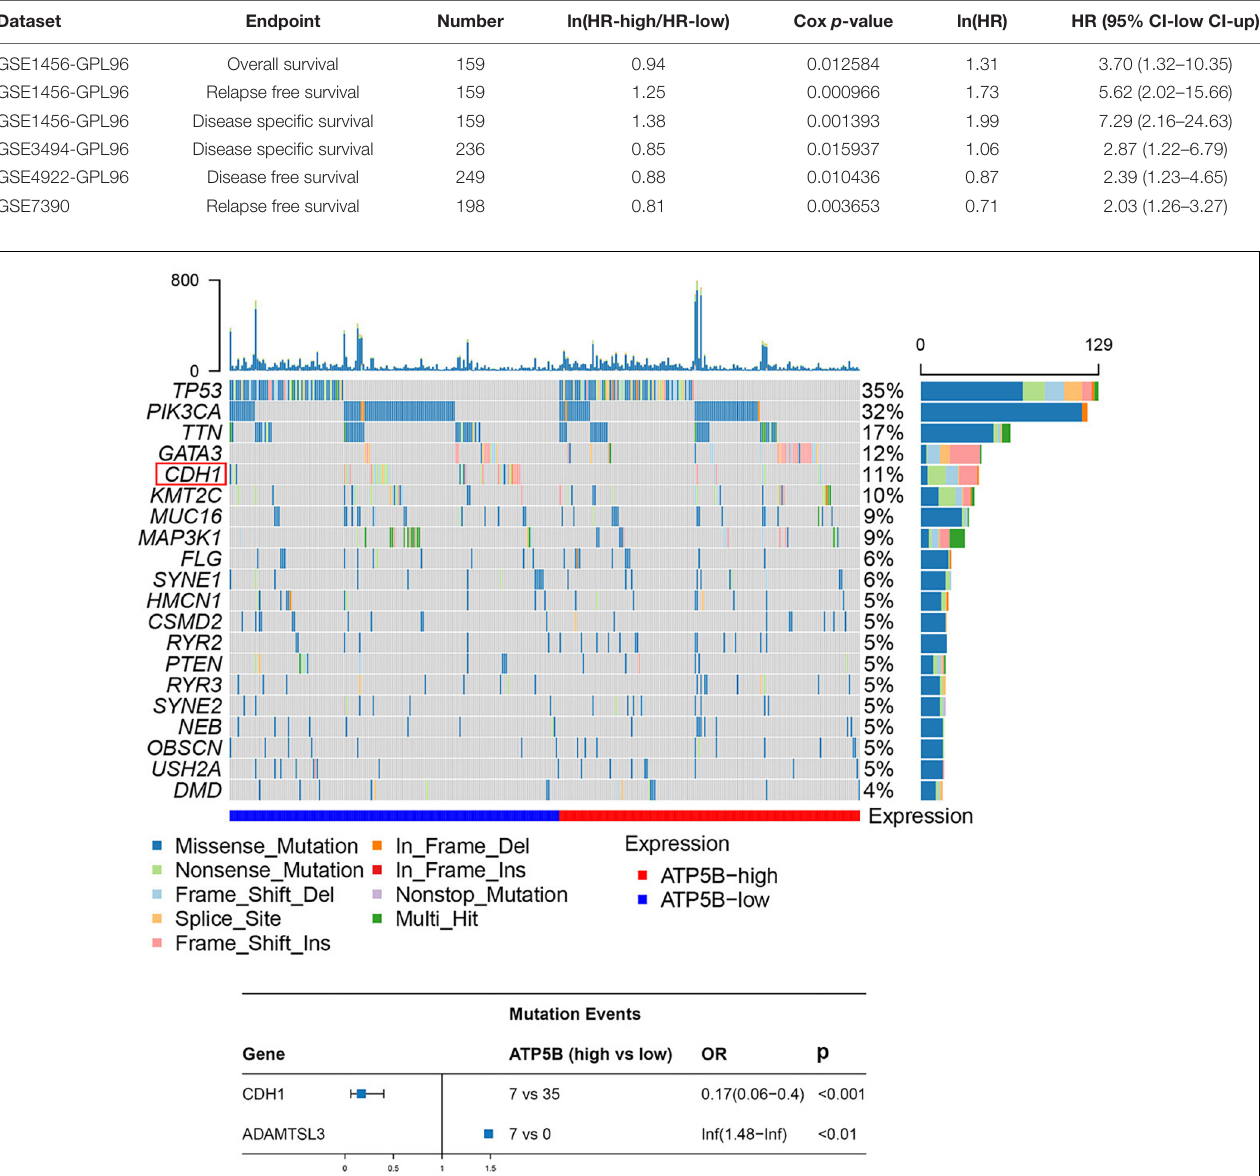
TABLE 3 | Survival analysis of ATP5B mRNA in breast cancer patients based on PrognoScan. Dataset